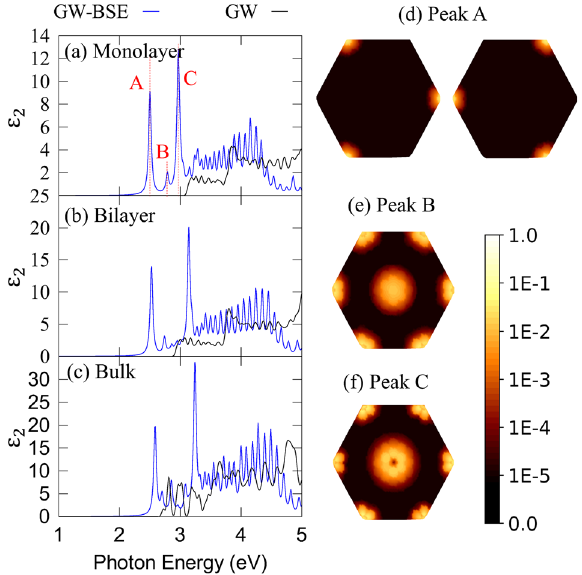
Fig. 5 Layer-dependent optical properties of MoSi 2 N 4 . a – c show the absorption spectra of MoSi 2 N 4 from monolayer to bulk, and ( d – f ) e-h pair amplitudes of the fi rst three absorption peaks of monolayer MoSi 2 N 4 .